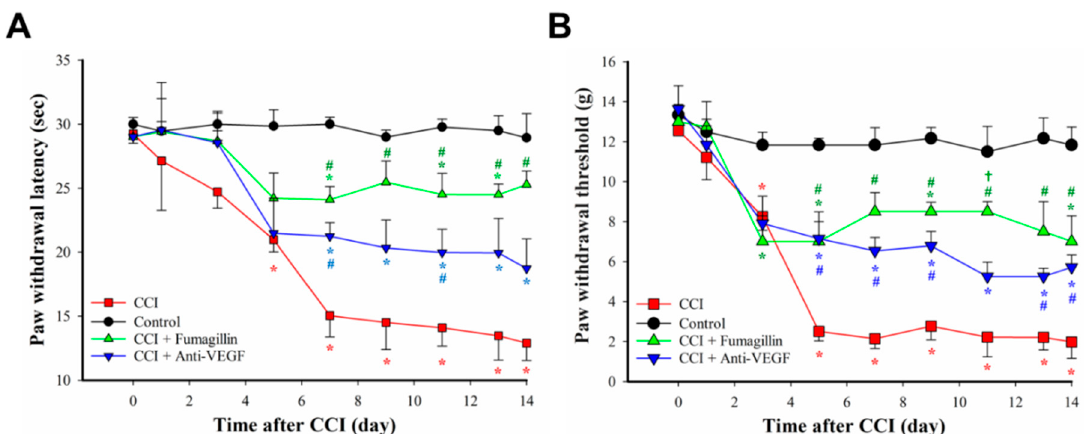
Figure 5. Effects of intrathecal administration of anti − vascular endothelial growth factor − A (anti − VEGF − A) monoclonal antibodies (0.3 µg/day) and fumagillin (0.1 µg/day) for 14 consecutive days on chronic constriction injury (CCI) − induced nociceptive behaviors. Thermal hyperalgesia, assessed by paw withdrawal latency (PWL) measurement ( A ), and mechanical allodynia, assessed by paw withdrawal threshold (PWT) measurement ( B ), were induced by CCI in rats. Data are expressed as means ± standard error of means (SEMs) of PWL in seconds and PWT in grams ( n = 3 rats for control, CCI + fumagillin, and CCI + anti-VEGF groups; n = 5 for CCI group). * p < 0.05 relative to the control group; # p < 0.05 relative to the CCI group; † p < 0.05 relative to the CCI + anti-VEGF group; one-way analysis of variance (ANOVA) with post hoc Tukey